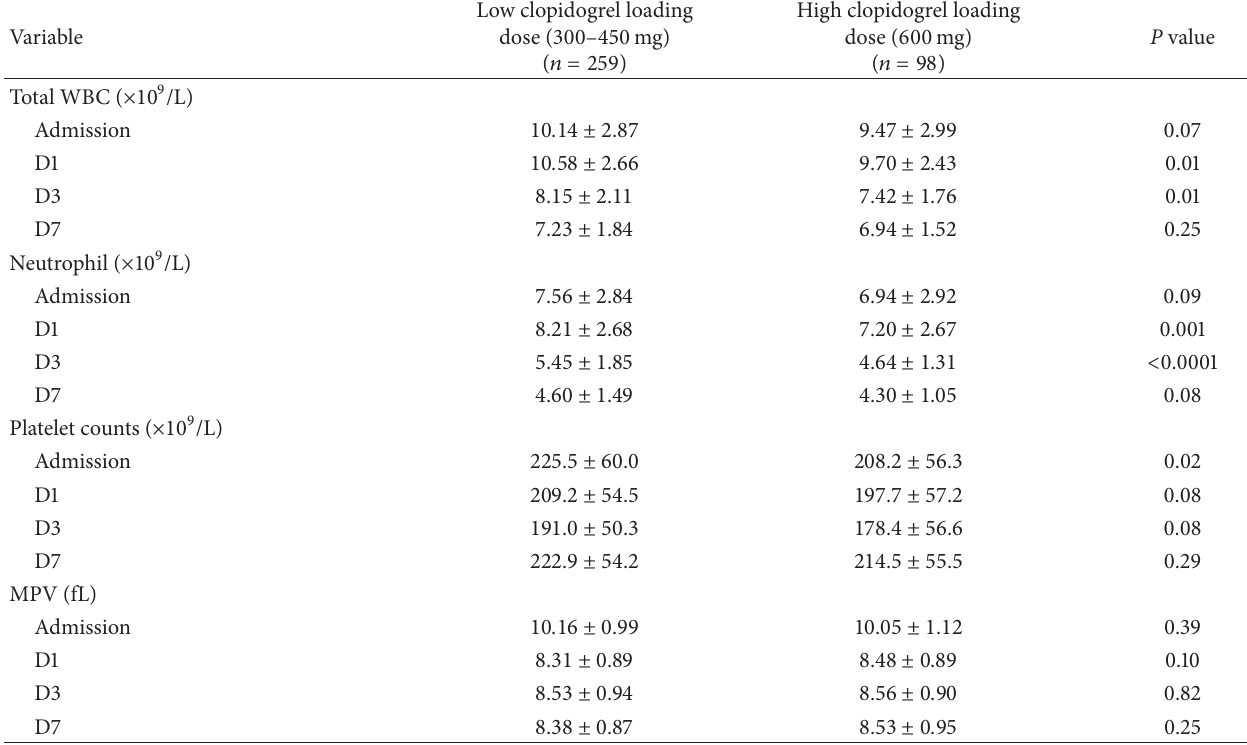
Table 3: WBC, neutrophil, and platelet related